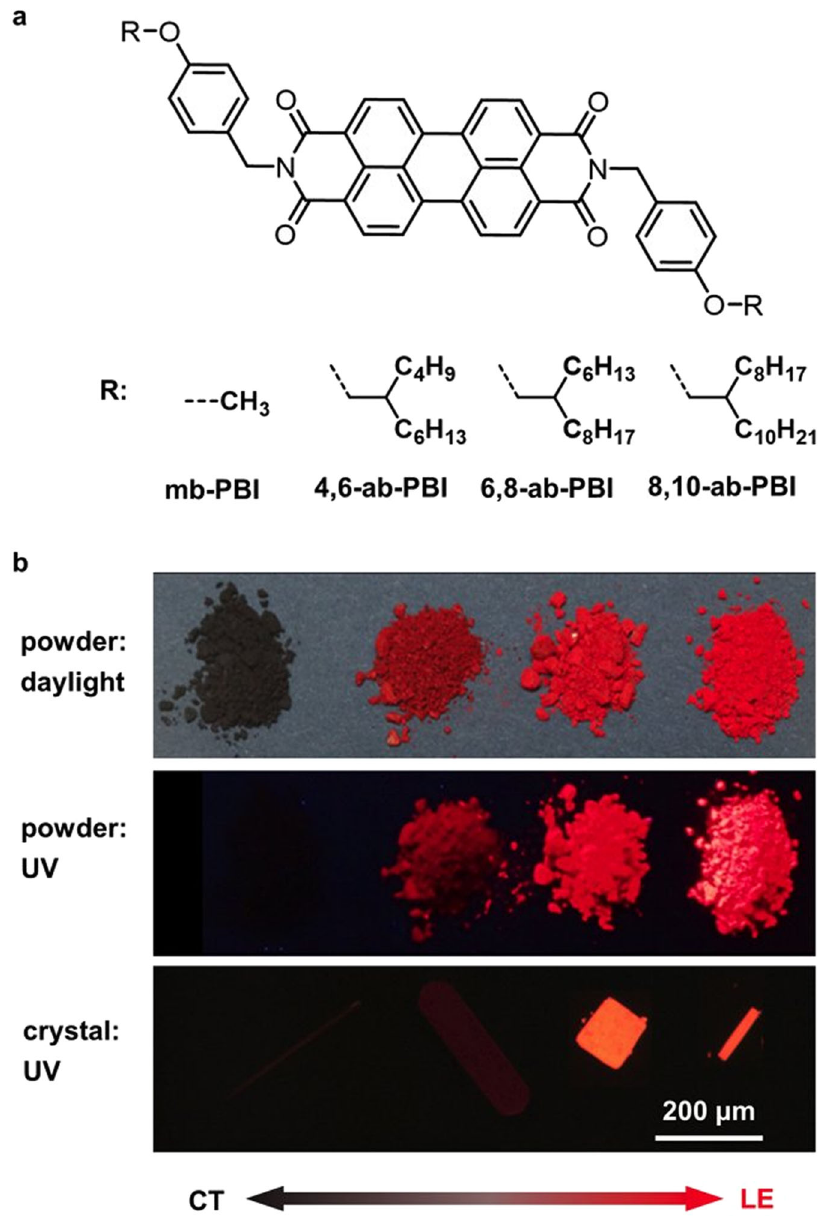
Fig. 1 | Molecular structure and photographs of powder and crystals. a Chemical structures of alkoxybenzyl substituted PBIs. b Photographs of the corresponding powders upon UV irradiation (365nm) and daylight as well as fl uorescence images of single crystals with exposure time of 158